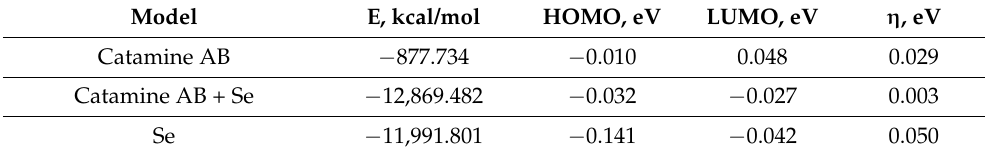
Figure 4. Simulation results of Se NPs stabilized with catamine AB: molecular complex model ( a ), electron density distribution ( b ), electron density distribution gradient ( c ), highest populated molecular orbital HOMO ( d ), lowest free molecular orbital LUMO ( e ). Table 6. Results of computer quantum-chemical modeling.